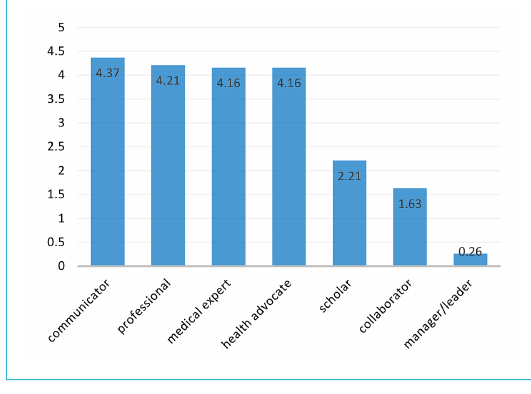
Figure 2: Residents’ ranking of their perceived proficiency of each CanMEDS role. Values correspond to the average score of the rankings (19 observations): 6 = best mastered role; 0 = least mas- tered role.